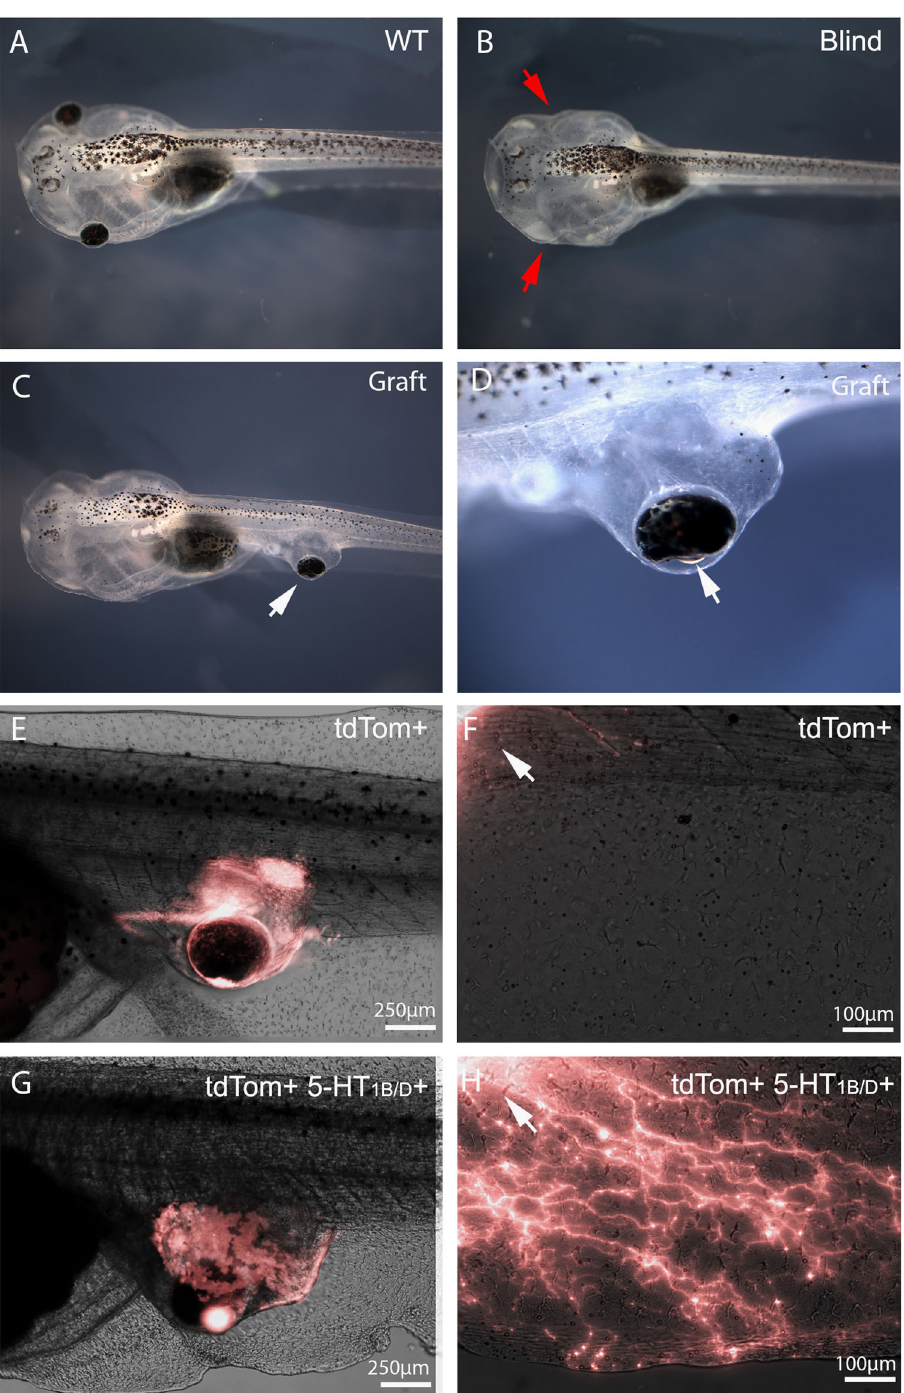
Fig. 1 Serotonin receptor 1B/D activation increases afferent innervation of eye grafts in Xenopus tadpoles. a Wild-type animals possess fully developed eyes by stage 47. b Microsurgery performed on stage 34 animals to remove developing eye tissue leads to blind animals that are otherwise healthy. c Grafts of eye primordia transferred from stage 24 donors to recipients result in ectopic eyes forming at the site of the graft. d Eyes forming from grafts display proper proximal-distal orientation with a clearly visible lens ( arrow ) facing outward from the body. e Grafts between tdTomato labeled donors and non-labeled recipients allow donor tissue to be visualized at later stages. f Higher magni fi cation of the region posterior to the graft ( white arrow ) reveals little innervation of the host, with few if any neurites present in the fi n or trunk region of the animal. g Treatment of grafts with the 5-HT 1B/D activator Zolmitriptan does not alter the morphology of the ectopic eye. h Higher magni fi cation of the region posterior to the graft ( white arrow ) reveals extensive afferent innervation in response to the treatment,